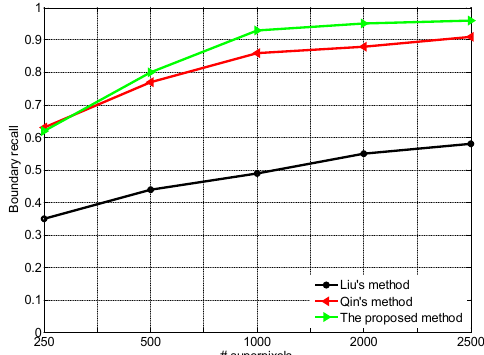
Fig. 5. Boundary recall (BR) of three methods with different superpixel numbers. Fig. 5 and Fig. 6 depict the BR and ASA of three methods with different numbers of superpixels, respectively. This number is set from 250 to 2500 with different step sizes. According